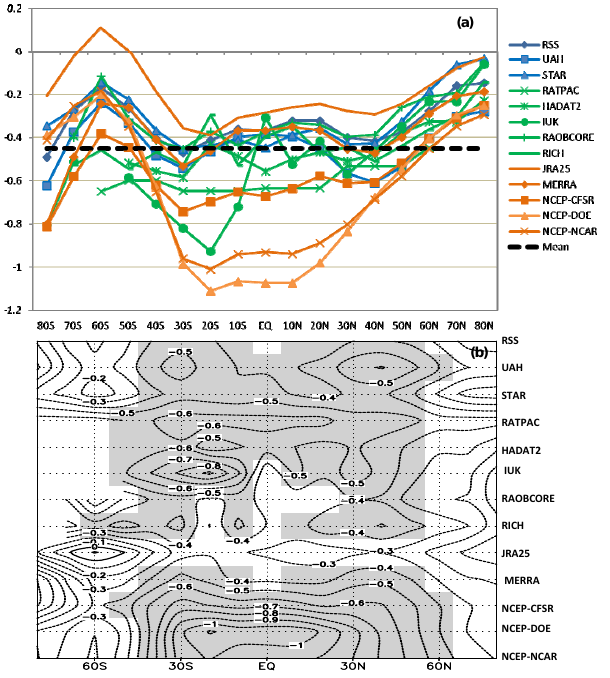
Fig. 1. Inter-comparison of stratospheric temperature ( T CH4 ) trends Fig. 1 Inter ‐ comparison of stratospheric temperature (T CH4 ) trends (K/Decade) for the MSU (RSS, UAH, STAR), Radiosonde(RATPAC, HADAT2, UK, RAOBCORE, RICH) and Reanalysis (JRA25, MERRA, NCEP ‐ (Kdecade − 1 ) for the MSU (RSS, UAH, STAR), Radiosonde (RAT- CFSR, NCEP ‐ NCAR, NCEP ‐ DOE) products for the period of 1979 ‐ 2008. (a) Trend changes with latitude for each individual dataset; (b)Latitudesections by data source for the trends ‐‐ the shaded PAC, HADAT2, UK, RAOBCORE, RICH) and Reanalysis (JRA25, areas indicated the statistical significance t ‐ test at the 99%. MERRA, NCEP- CFSR, NCEP-NCAR, NCEP-DOE) products for the period of 1979–2008. (a) Trend changes with latitude for each individual dataset; (b) latitude sections by data source for the trends – the shaded areas indicated the statistical significance t-test at the 99%.